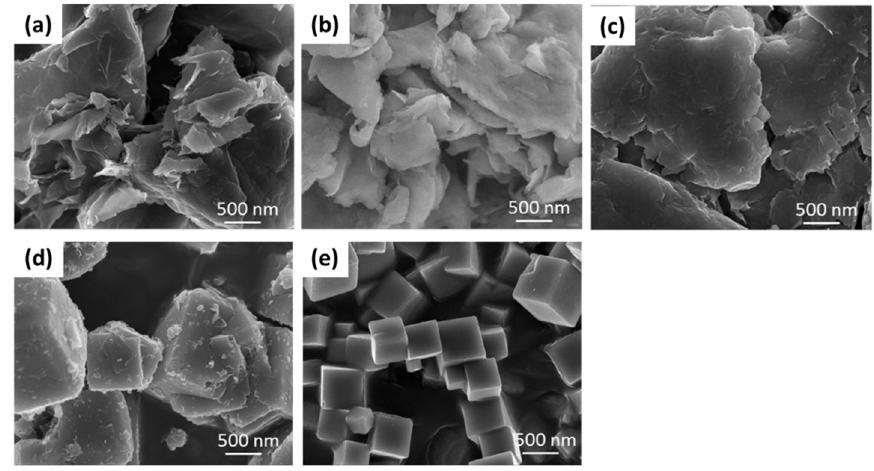
Figure 2. Scanning electron microscopy (SEM) images of montmorillonite ( a ), His–Ag–Mont ( b ), Met–Ag–Mont ( c ), silver zeolite (AJION) ( d ), and silver zirconium phosphate (NOVARON) ( e ). Figure 3a shows the XRD pattern. Montmorillonite revealed a strong peak at 2 θ = 6.95° (d = 1.27 nm) and a weak peak at 14.1° (d = 6.29 nm). Met–Ag–Mont revealed a strong peak at 2 θ = 5.16° (d = 1.71 nm) and a weak peak at 10.3° (d = 0.86 nm). His–Ag–Mont revealed a strong peak at 2 θ = 4.61° (d = 1.92 nm).